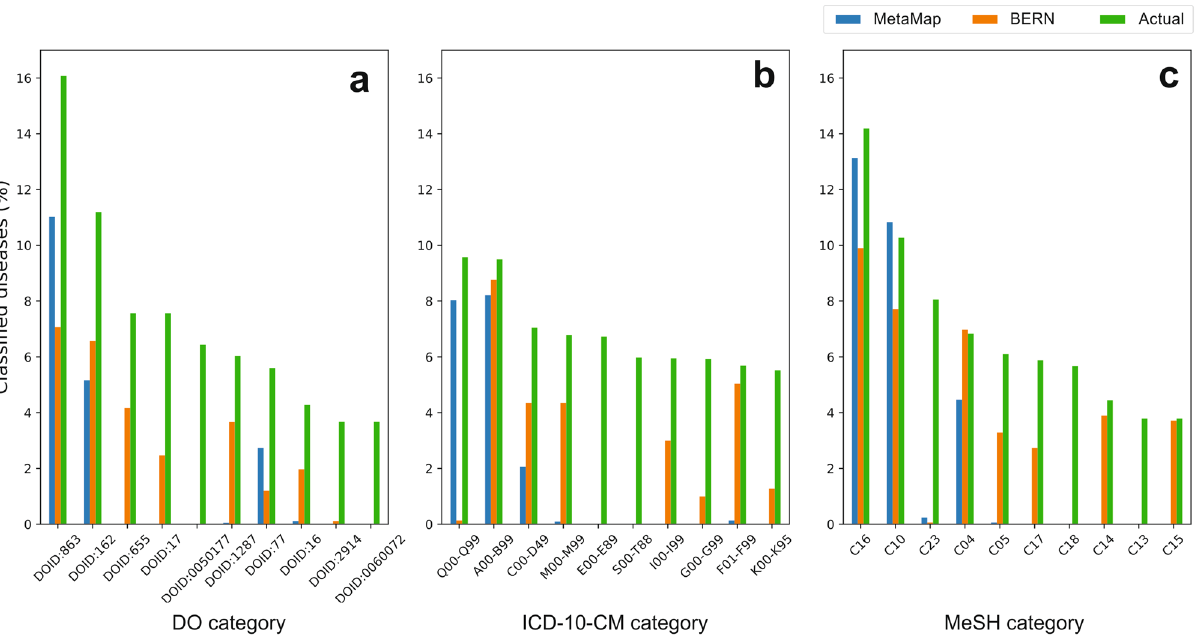
Figure 3. Coincidence of network communities with disease categories. The bar plots show the proportion of diseases associated with the 10 largest first-level categories in the DO ( a ), ICD-10-CM ( b ) and MeSH ( c ) classification systems, compared with the proportion obtained for the best performer (BERN) and worst performer